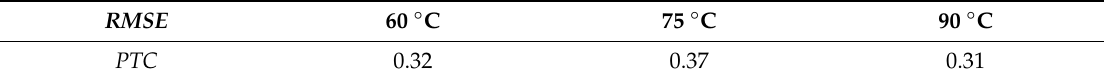
Figure 8. RE of the calculation curves and the measured curves based on the “master curve” technique.